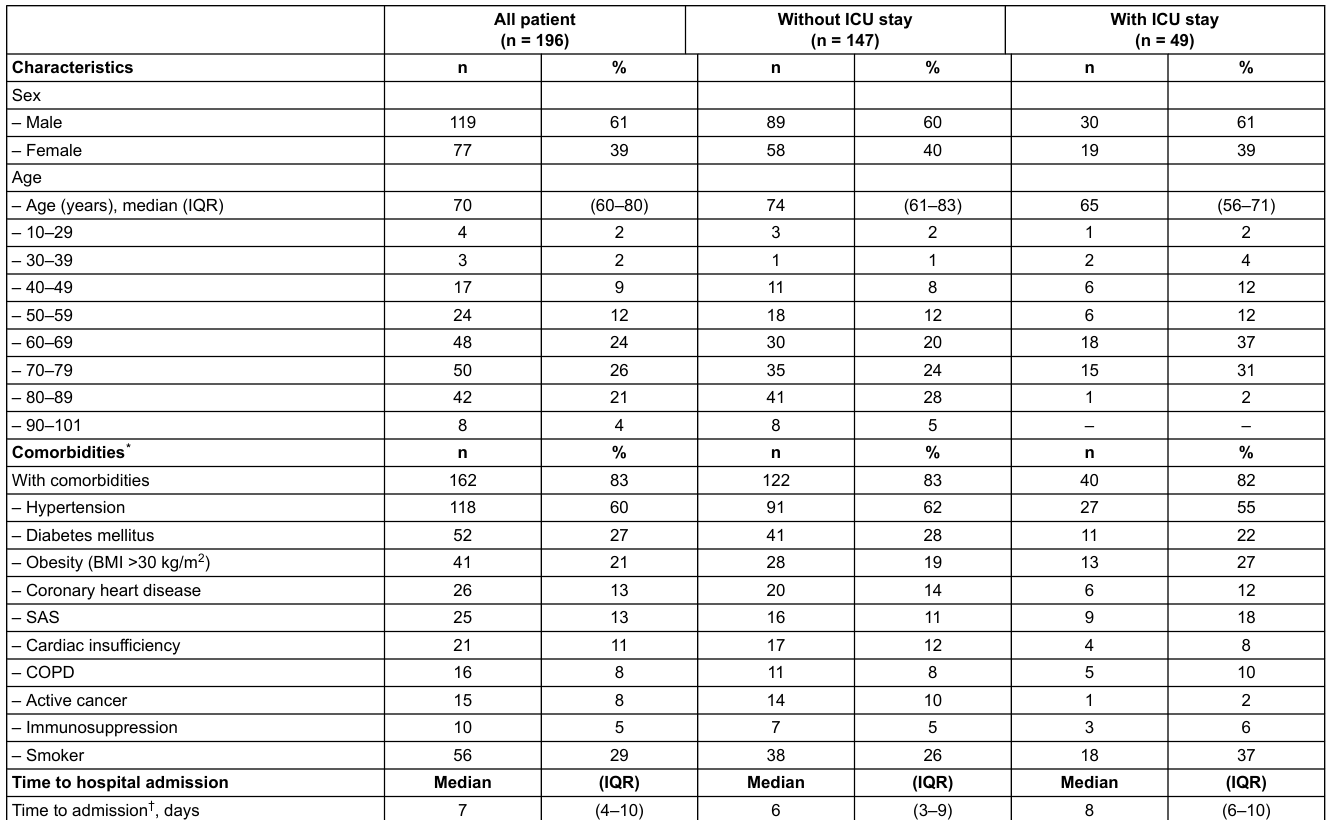
All patient (n = 196)